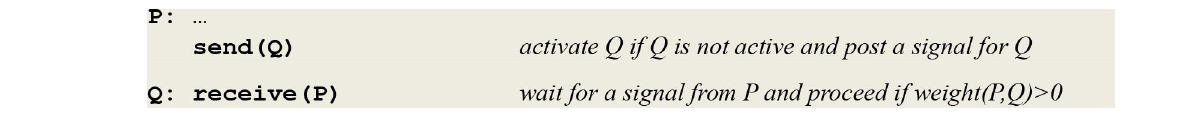
FIGURE 4 | Communication protocol for an asynchronous communication. The send/receive protocol corresponds to an asynchronous communication subject to a threshold. It involves a predefined weight between the sender P and the receiver Q. This weight can be incremented/decremented by an ltp/ltd thread (see below). After firing thread Q and sending it a signal, thread P goes on executing its next instruction. On the other side, thread Q waits for the reception of a signal from thread P and proceeds only if the weight between P and Q stands above a given threshold.